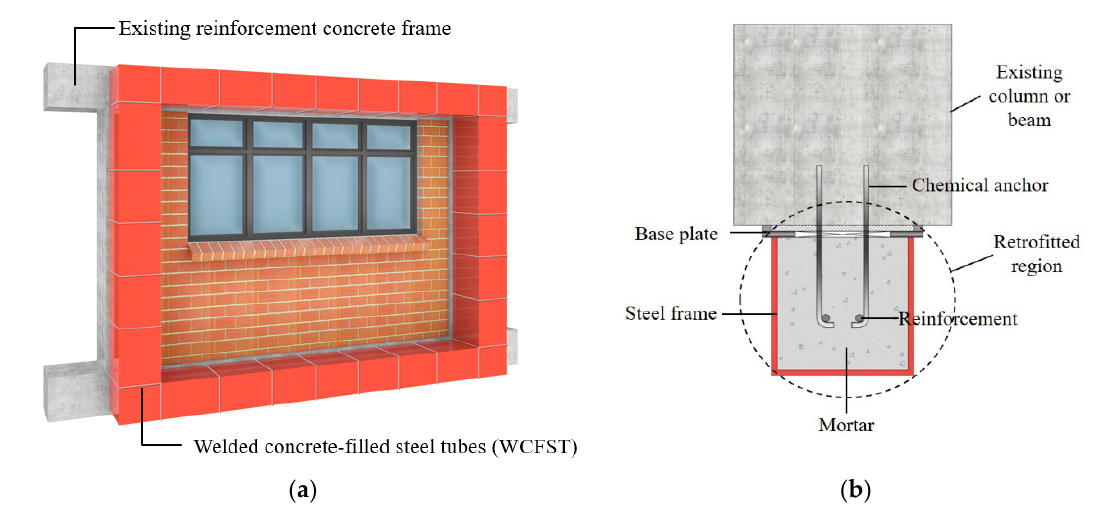
Figure 1. Welded concrete-filled steel tube (WCFST) retrofitting scheme for the reinforced concrete (RC) frame: ( a ) front elevation and ( b ) section.